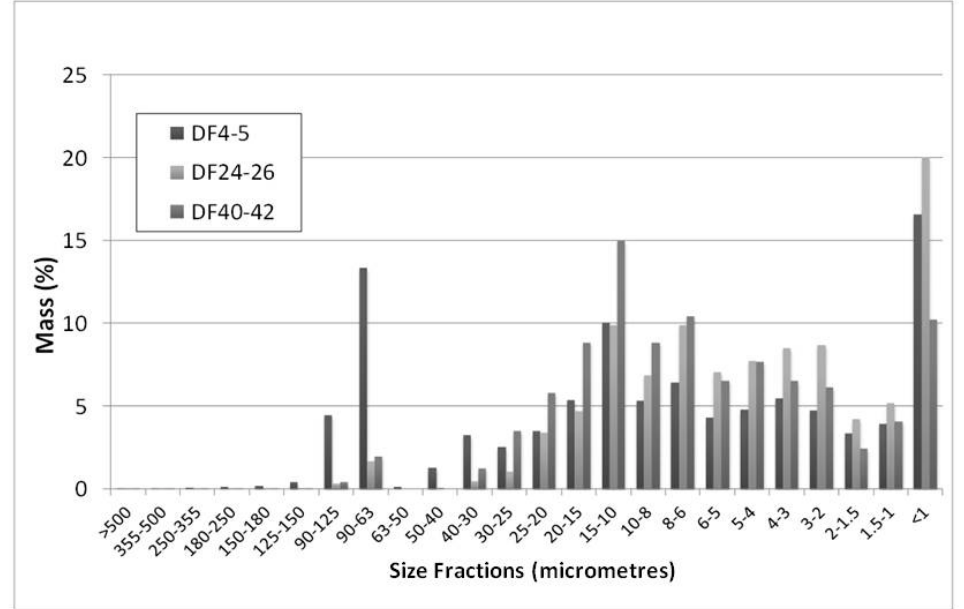
Figure 2. Mass distribution (%) of three samples (DF 4-5, DF 24-26, DF 40-42), used to select grain size classes (micrometres) for analyses on size fractionated sediments.